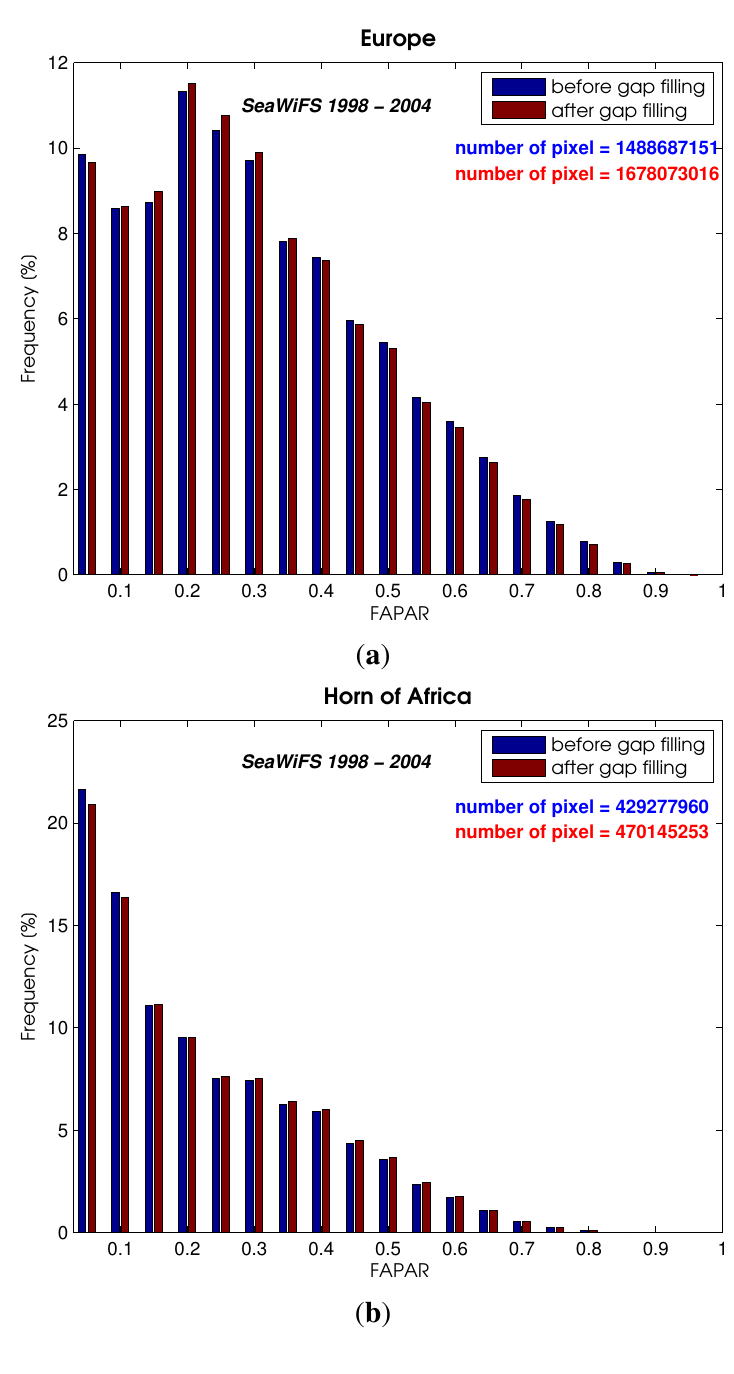
Figure 6. FAPAR distribution from SeaWiFs records ( i.e. , 1998–2004) before (blue bars) and after (red bars) gap filling over Europe ( a ) and over the Horn of Africa ( b